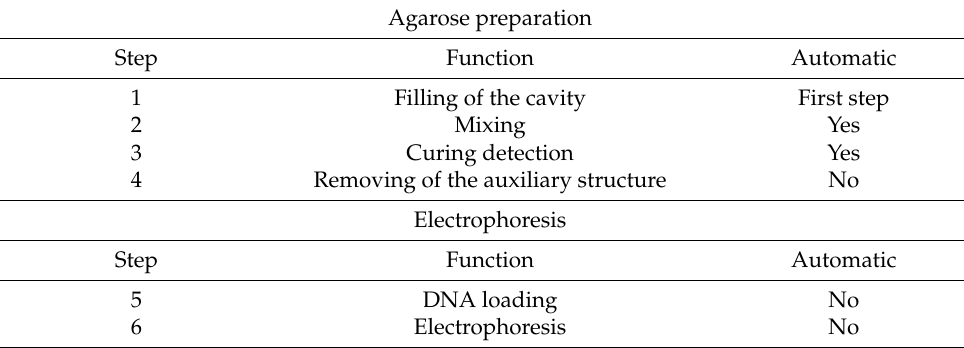
Table 1. Whole process sequence for agarose gel preparation and